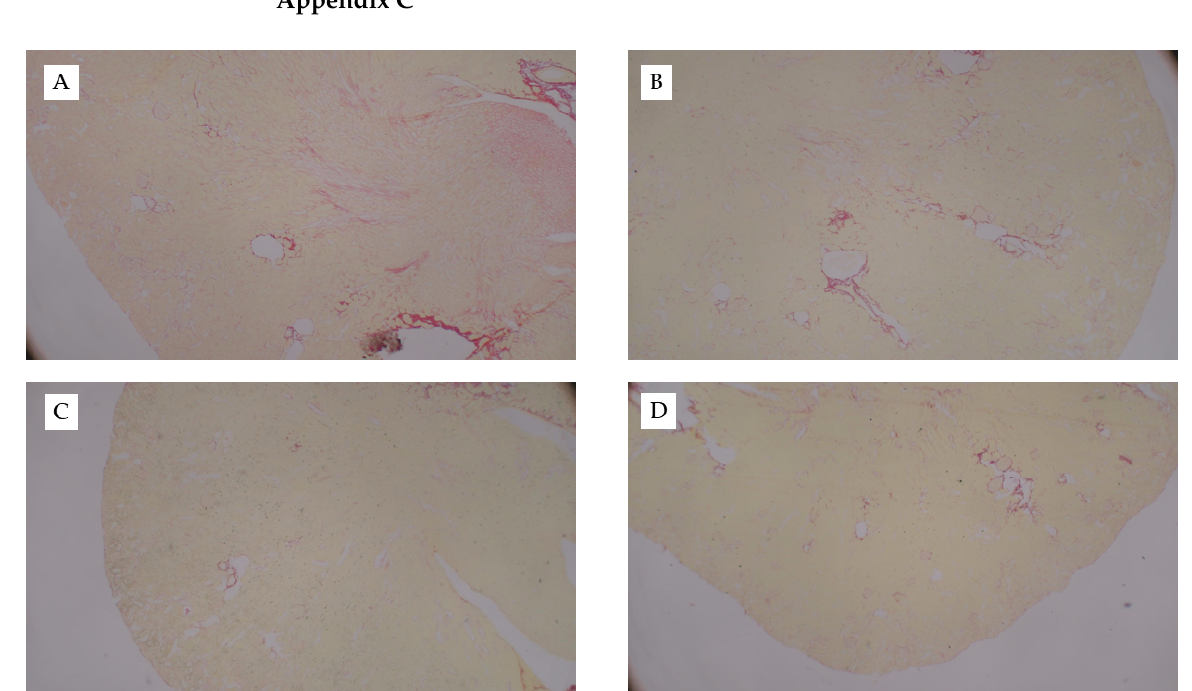
Figure A1. Picro Sirius-Stained Kidney Sections from FAN Study. Representative images of Picro Sirius-stained kidney